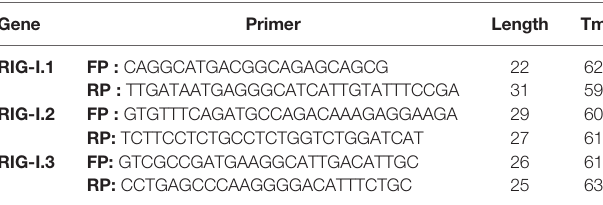
TABLE 1 | Primers used for ampli fi cation of RIG-I gene of Garole sheep as overlapping